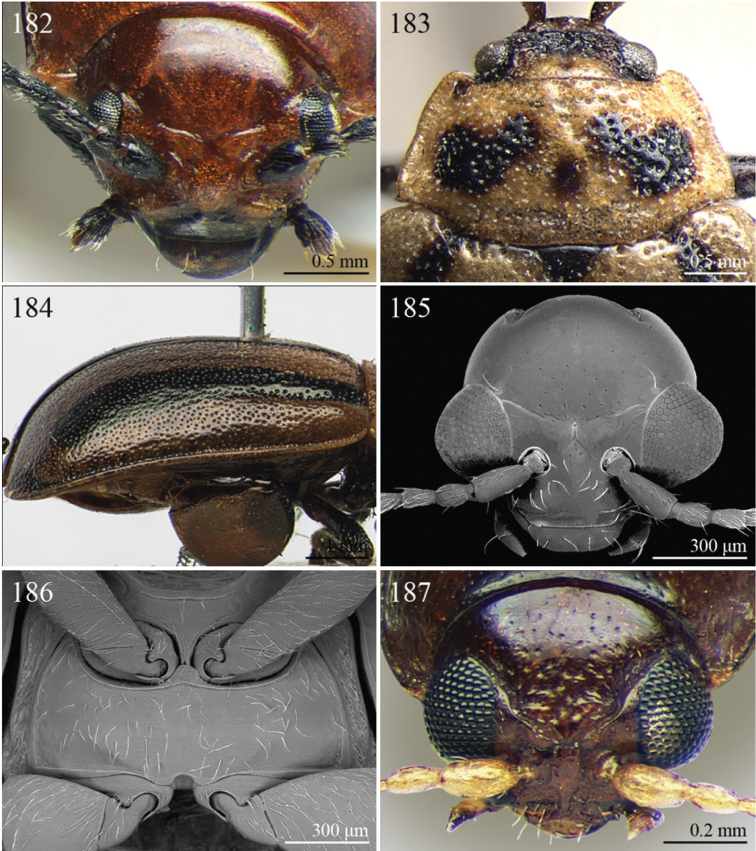
Morphological characters. 182
Eurylegna rubra (Weise), head in frontal view 183 Eutornus dilatatus Bryant, head and pronotum in dorsal view 184
Eutornus taeniatus Bechyné, elytra in lateral view 185
Gabonia nigripennis (Jacoby), head in frontal view 186 Ditto, meso- and metasternum 187
Guinerestia rubra Scherer, head in frontal view.